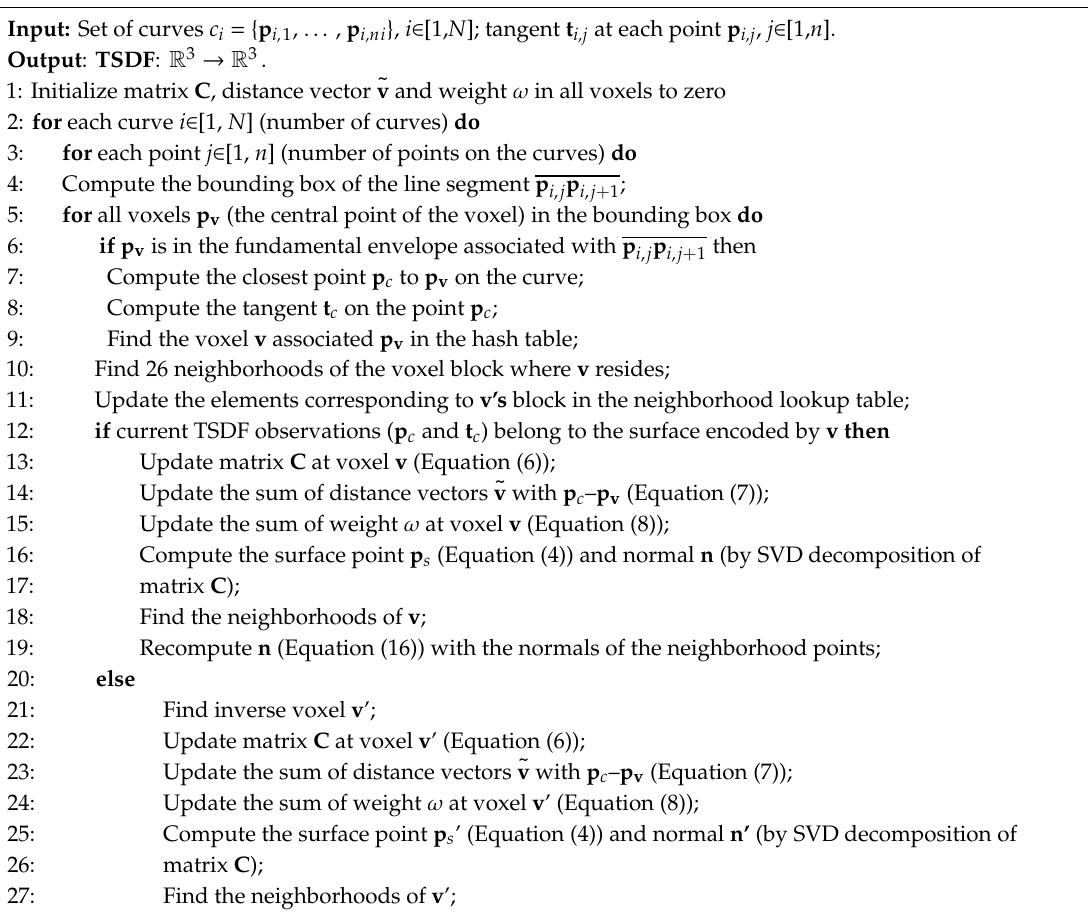
Algorithm 1. Computation of the TSDF from a set of